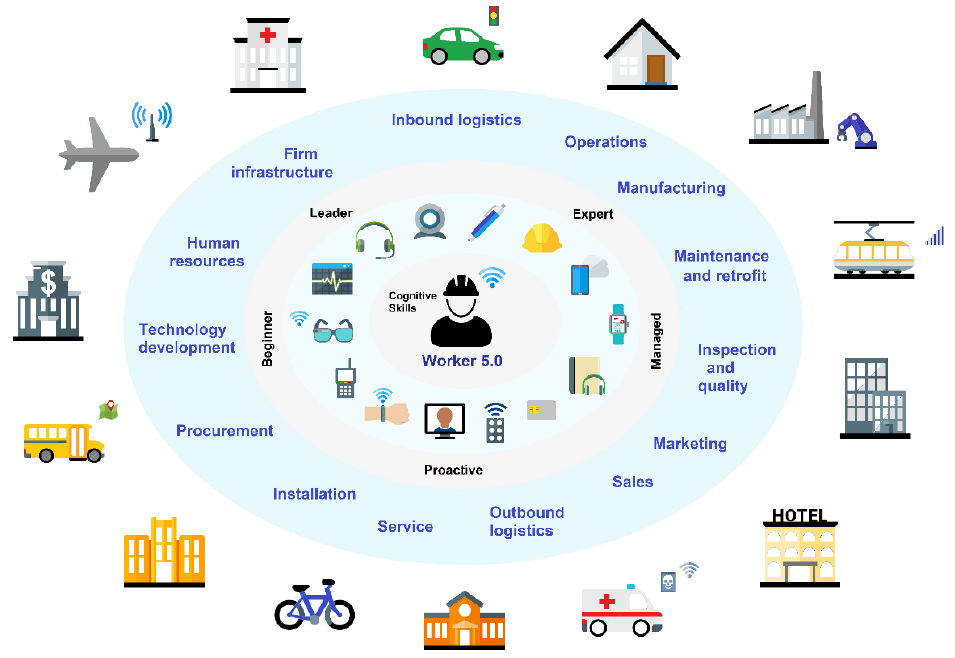
Figure 8. Worker 5.0 ecosystem.